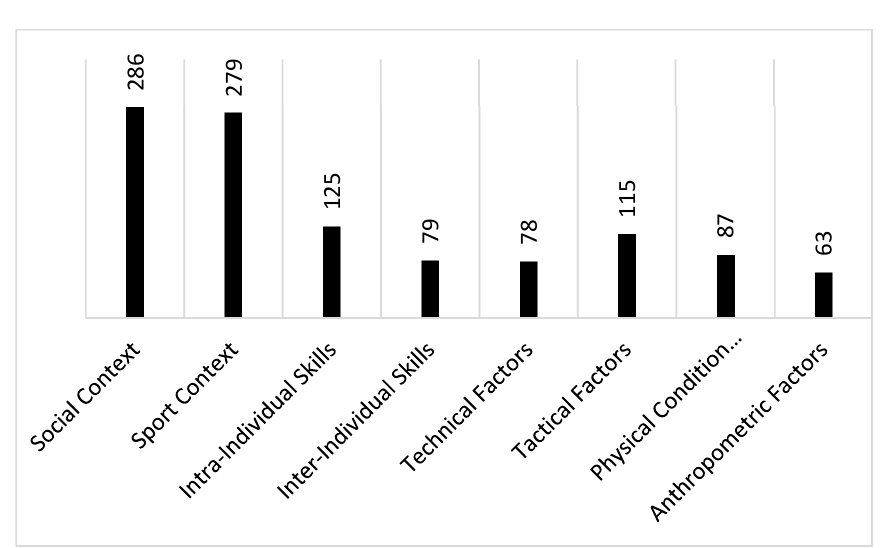
Figure 1. Quantitative data analysis: meaning units coded in the present study.